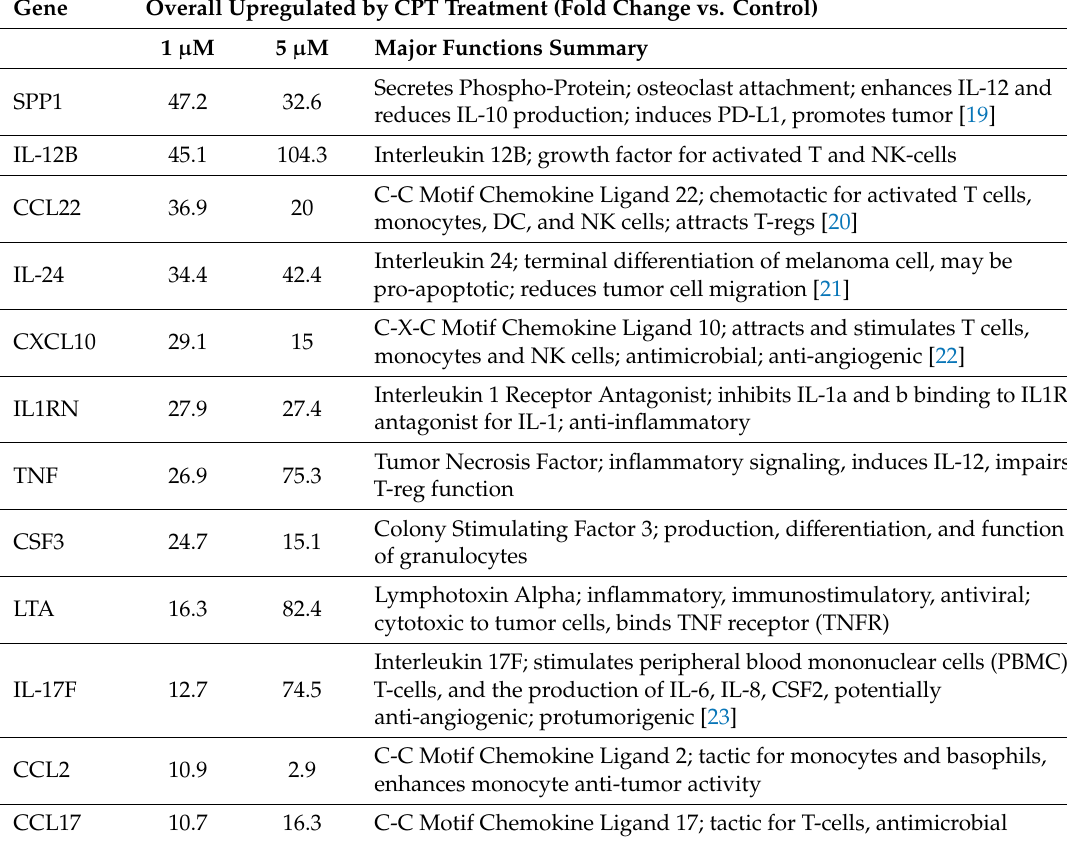
Table 1. Functional annotation of cytokines upregulated by treatment of SW620 cells with CPT. The list was sorted in decreasing order for fold expression induced by 1 µ M CPT. Summaries of primary functions were collected from Gene Cards annotations